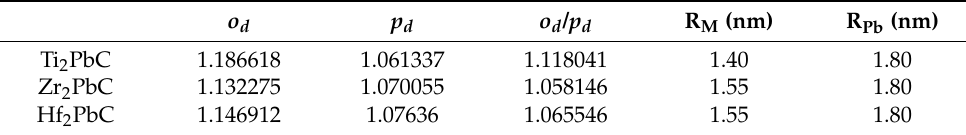
Table 4. Octahedron, o d , trigonal prism, p d , distortion parameters, their ratio for M 2 PbC (M = Ti, Zr, Hf). Atomic radius of M elements is also